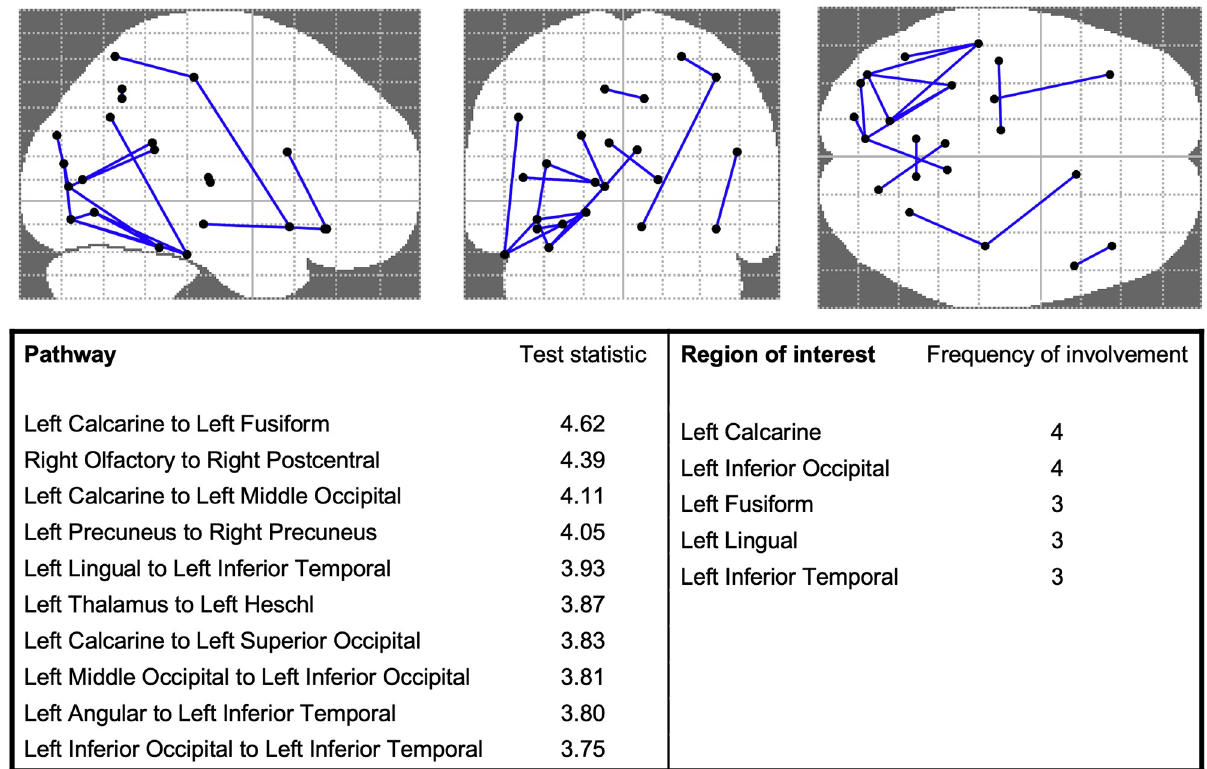
Fig 5. Hypoconnected pathways and associated regions of interest in congenital heart disease. After controlling for a false discovery rate and corrected gestational age at MRI, 18 weaker connections involving 22 ROIs were identified in CHD. The top 10 hypoconnections are listed, along with associated their test statistics. The top 6 ROIs most frequently involved in the hypoconnected pathways are also listed. A pictorial representation of the hypoconnections and associated ROIs is